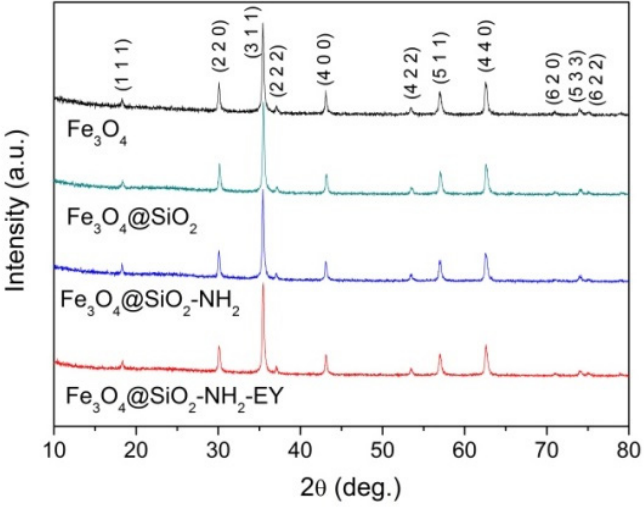
Figure 1. XRD patterns of synthesized NPs. The reflexes corresponding to PDF Card # 04-005-4319 are indicated in